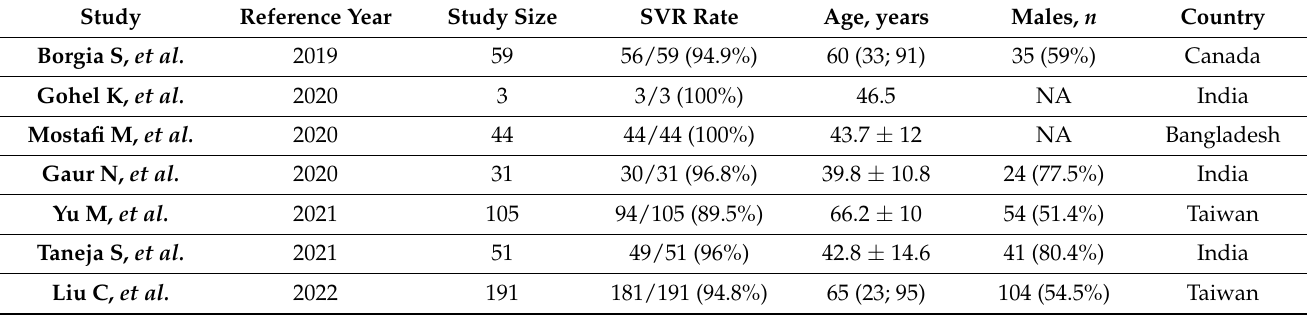
Table 3. Studies on SOF/VEL in advanced CKD: characteristics of study patients (and viral response).